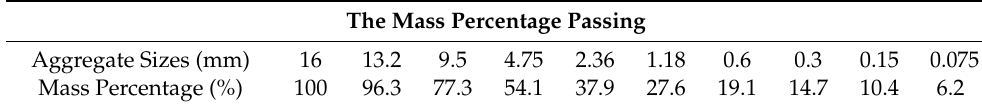
Table 1. Gradation of AC-13 asphalt mixture.